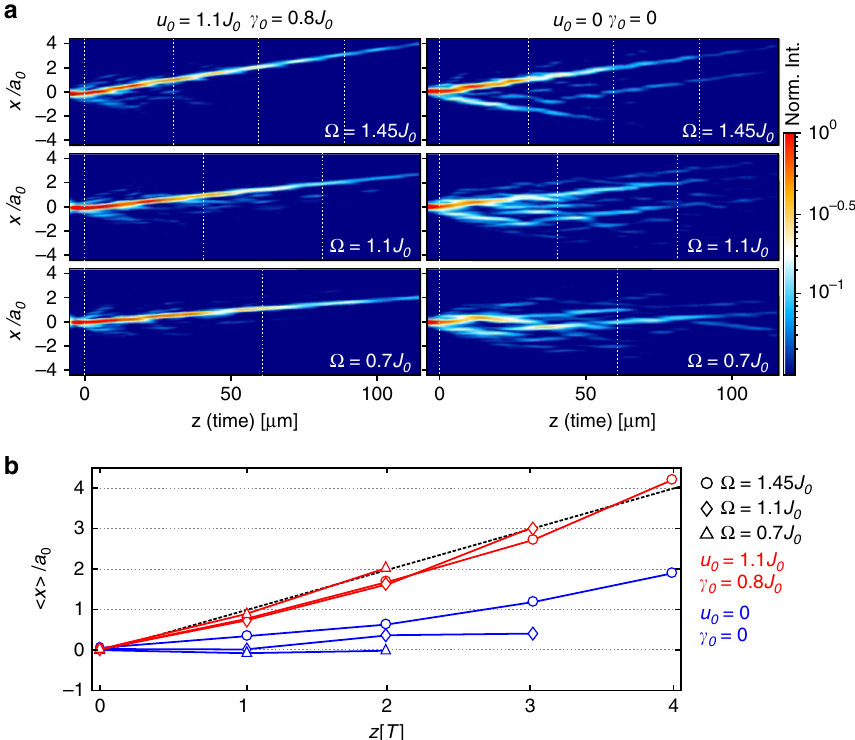
Fig. 6 In fl uence of driving frequency on the transport. a Real-space SPP intensity distributions for different driving frequencies and single-site excitation at waveguide A . The left and right column correspond to arrays with cross-section modulation ( u 0 = 1.1 J 0 , γ 0 = 0.8) and without cross-section modulation ( u 0 = 0, γ 0 = 0), respectively. b The CoM position of the SPP intensity in dependence on propagation distance z calculated from the experimental results shown in a . Note that the z -axis here is normalized to the period T . Red markers correspond to arrays with cross-section modulation and blue markers correspond to no modulation. The black dashed line shows the anticipated adiabatic